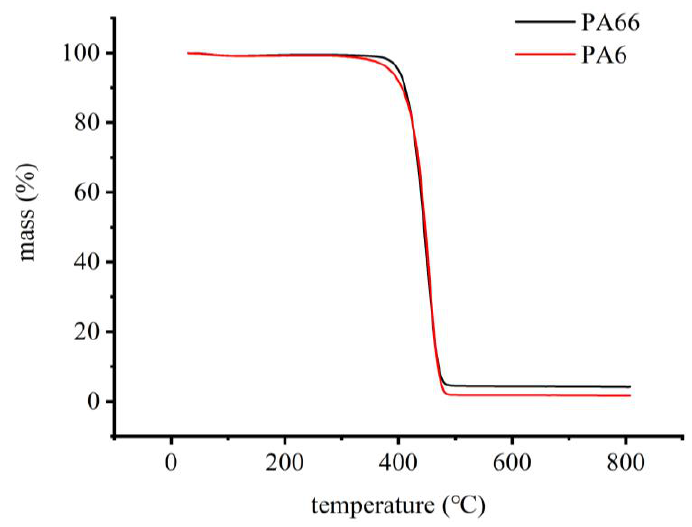
Figure 6. Thermogravimetric analysis of PA6 and PA66.